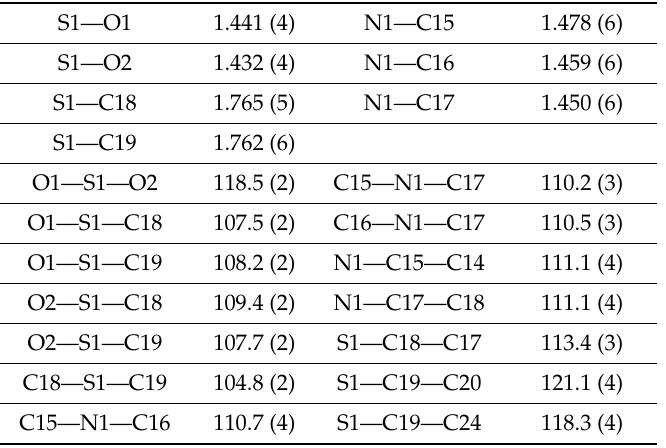
Table 2. Selected geometric parameters (Å, ◦